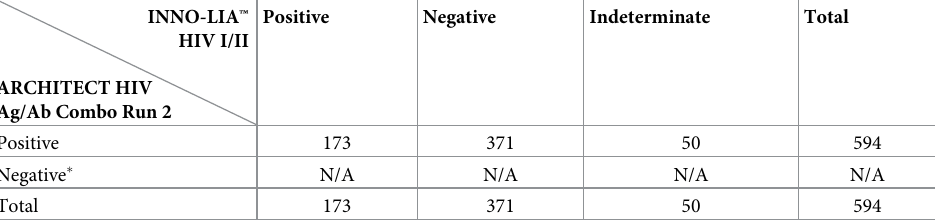
Table 2. Comparison between ARCHITECT 1 HIV Ag/Ab combo run 2 and INNO-LIA ™ HIV I/II.